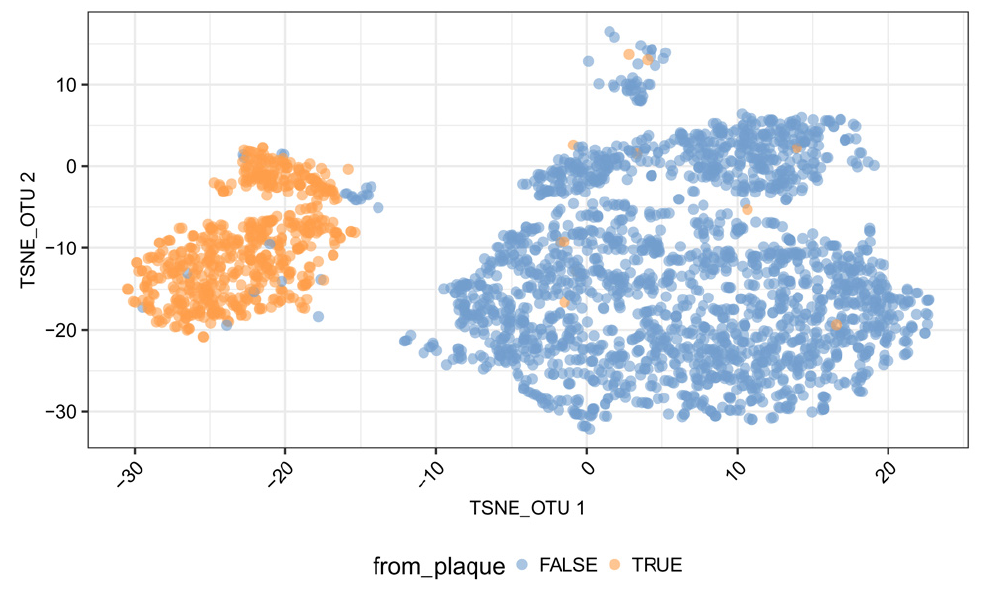
Figure 10. t-distributed Stochastic Neighbor Embedding (t-SNE) plot of samples from the oral site using data at the OTU level. The two t-SNE components computed are plotted. Each point is a sample. Samples from the ‘supragingival or subgingival Plaque‘ are in orange, and those from other oral sub-sites are in blue.